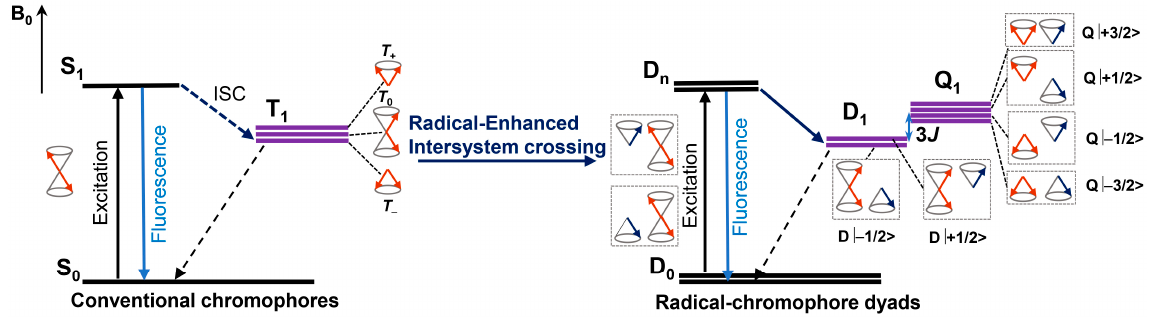
Figure 1. The mechanism of REISC in the chromophore-radical dyads. D 0 : doublet ground state, D n : excited doublet state, D 1 : the lowest excited doublet state, Q 1 : the lowest excited quartet state, 3 J : energy splitting ( J < 0), T + , T 0 , T − , D |+ 1/2 > , D | − 1/2 > , Q |+ 3/2 > , Q |+ 1/2 > , Q | − 1/2 > , Q | − 3/2 > : sublevel, B 0 : magnetic field. Reproduced with permission from reference [28], copyright 2021, American Chemical Society.